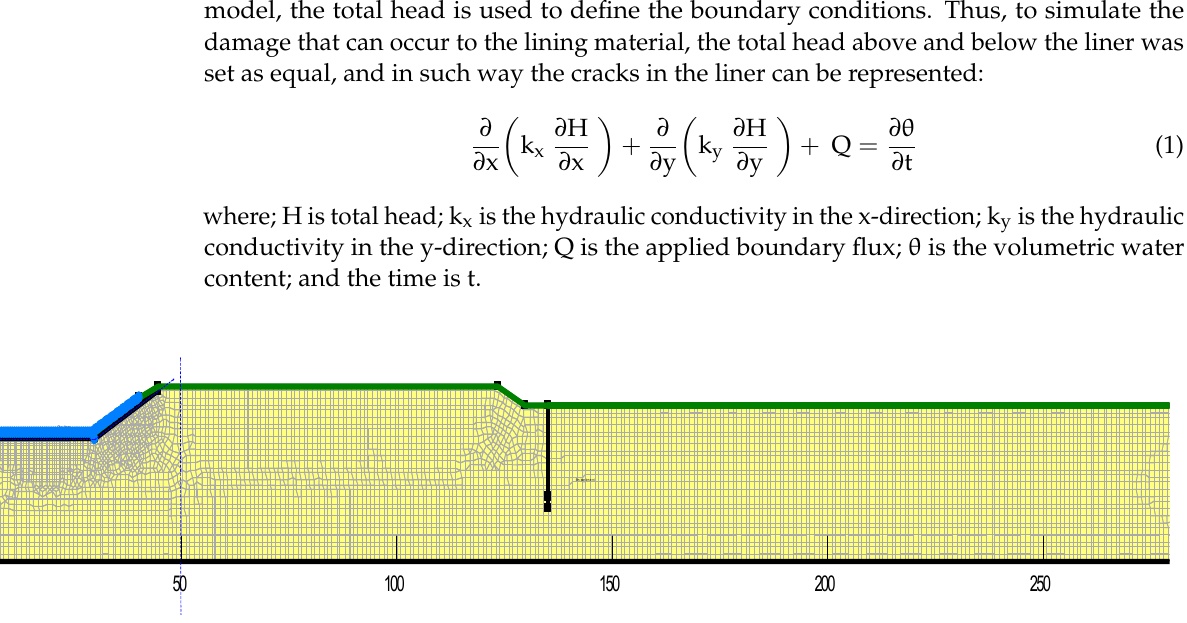
Figure 3. Schematic diagram of the numerical model of the Ismailia canal for the stretch 28.00–49.00 km.